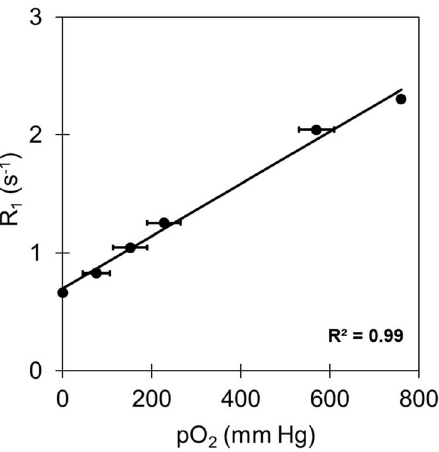
Figure 1. Invitro calibration curve for R 1 =1/T 1 versus pO 2 . Here, solid circles represent average 19 F R 1 measurements of six oxygen partial pressure values, each in triplicate, ranging from 0% to 100% oxygen in a saturated O 2 /N 2 mixture of PFC emulsion in water. The solid line is the calibration curve fit by the linear least squares method (R 2 =0.99). Data were collected at 11.7 T and 37 u C. 100% oxygen is equivalent to 760 mm Hg. (The R 1 error bars are smaller than the point